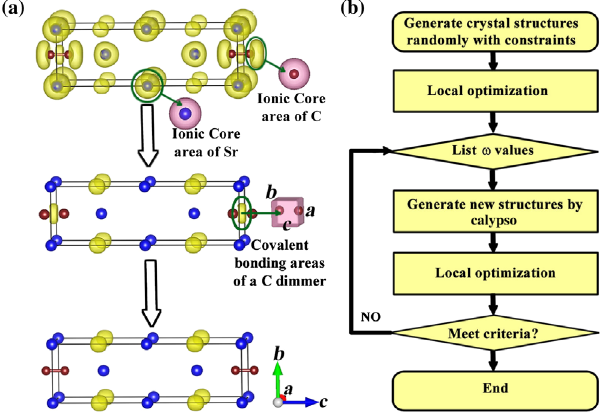
FIG. 1. Computational details of calculation of ω and inverse- design scheme for electrides. (a) A step-by-step process of calculating V in a tetragonal Sr 2 C crystal. In the ELF map inter with an isosurface of 0.75, the regions for localized electrons are shown as yellow. Exclusion of ionic cores areas for localized electrons from the crystal as illustrated by Sr and C atoms (top panel). Exclusion of C ─ C covalent bonding areas from the crystal (middle panel). The volume of the interstitial areas where the electrons are localized ( V , shown as yellow in ELF map in inter bottom panel). (b) Flow chart of the CALYPSO module for searching for electrides with the inverse-design